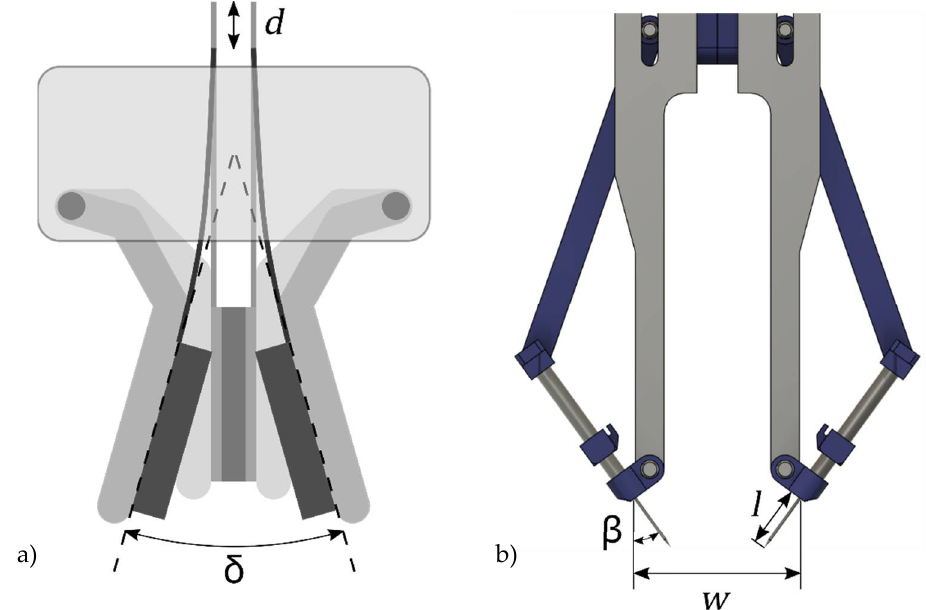
Figure 1. Gripper concepts: a) two-finger; b) needles.